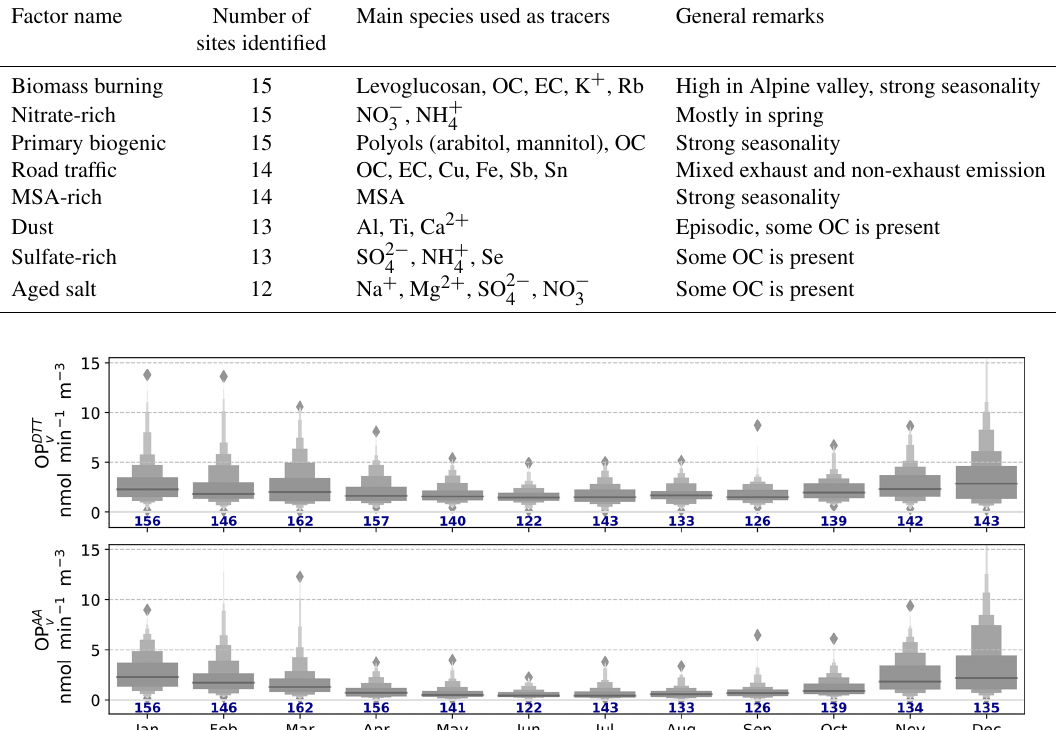
Figure 2. Box plot of OP DTT v and OP AA v seasonal values. The numbers in the x axis indicate the number of observations. Each box represents one decile, and the black horizontal lines indicate the median of the distributions. Some values greater than 15 . 5nmolmin − 1 m − 3 are not displayed for graphical